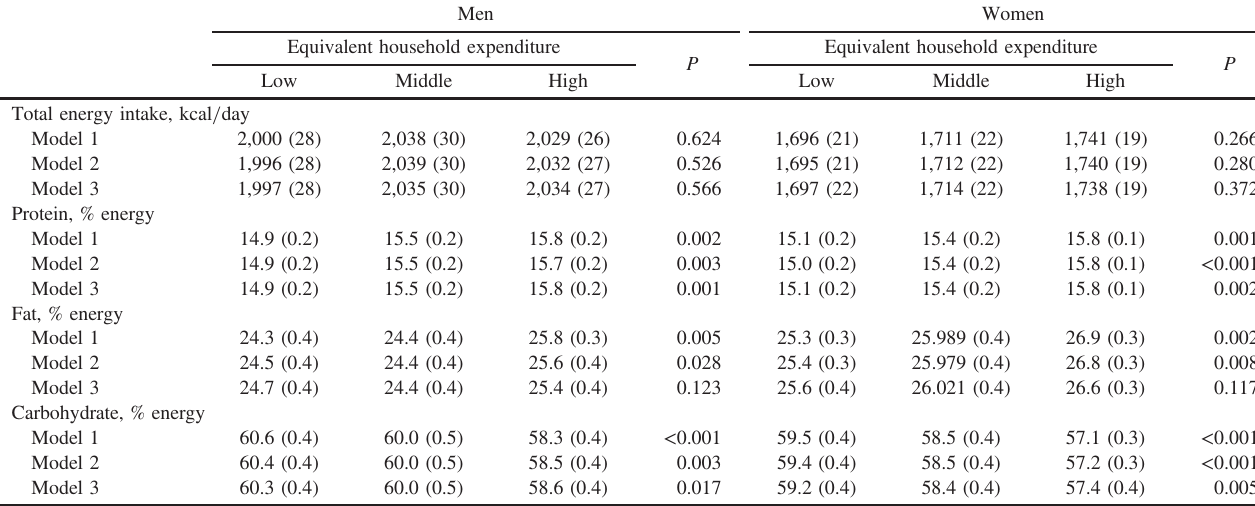
Table 4. Adjusted intakes of macronutrients according to equivalent household expenditure: NIPPON